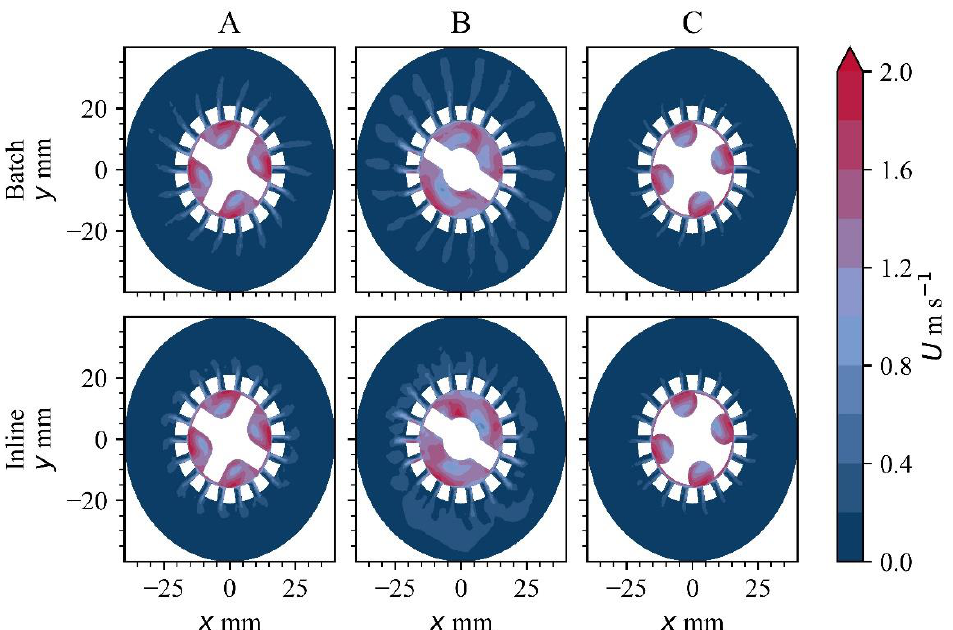
Figure 3. Velocity contours along the plane cutting through the third row of holes in the mixer, corresponding to z = 13 mm (confer Figure 1 for the frame of reference) for a rotor speed of 1000 RPM predicted using the k- ω SST turbulence model. The top row of contours corresponds to batch mode and the bottom row to continuous mode. The rotor moves anticlockwise.